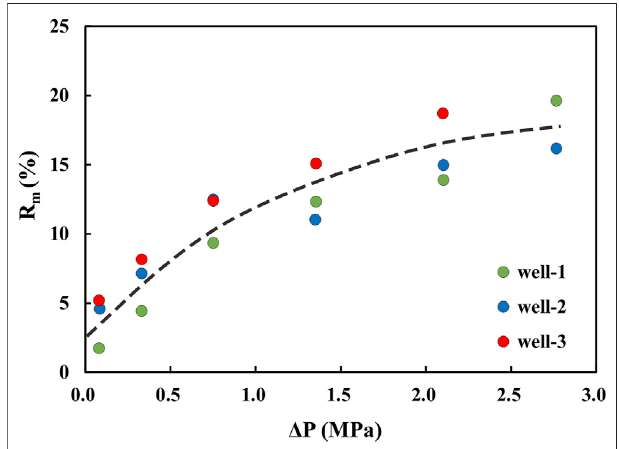
FIGURE 7 | Relationship between movable ratio and centrifugal